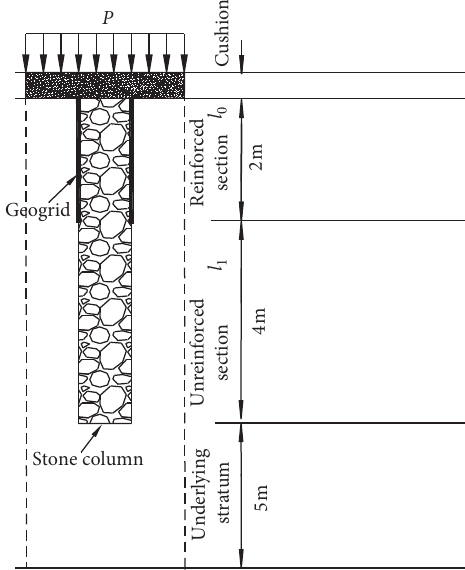
Figure 6: Distribution of pile and surrounding